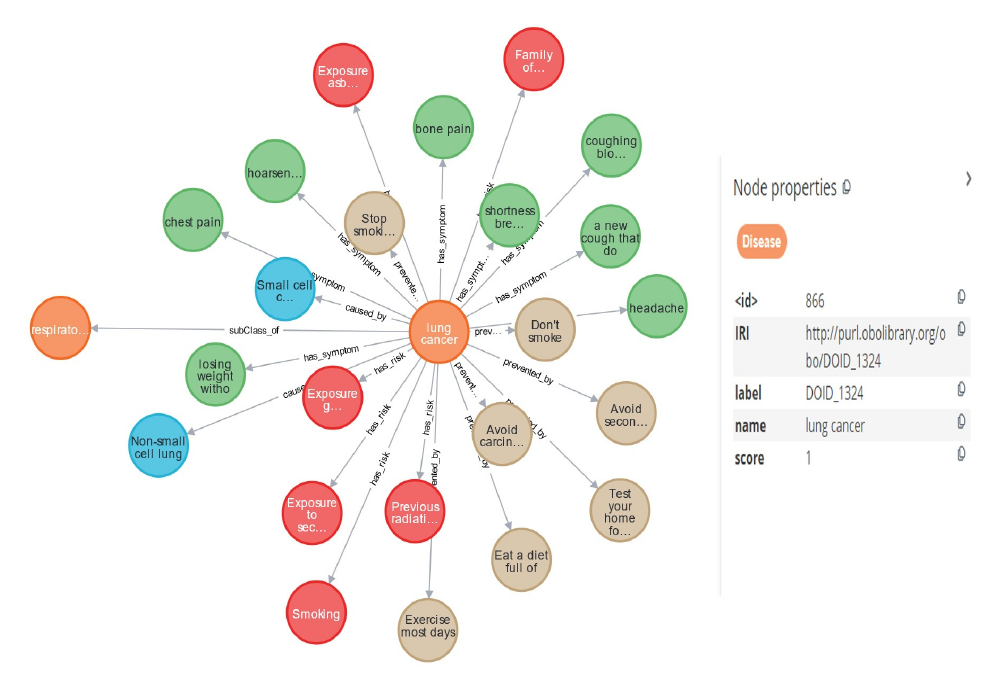
Figure 8. The subgraph of the integrated node ‘lung cancer’ with all its relationships and its node prop- erties.